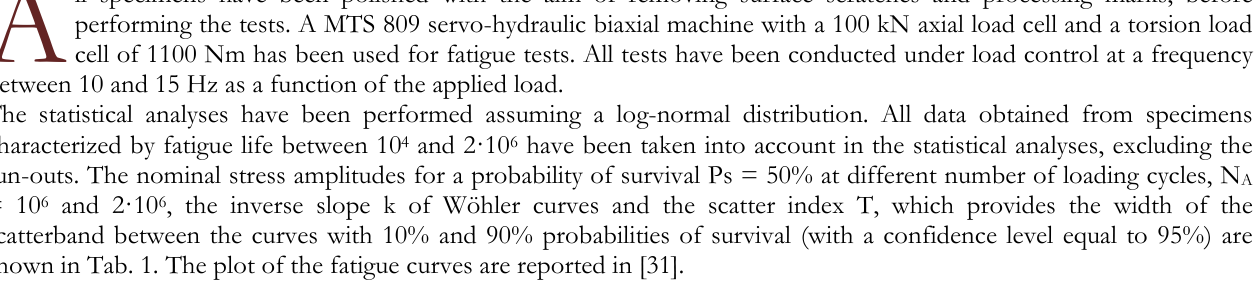
R ESULTS FROM FATIGUE